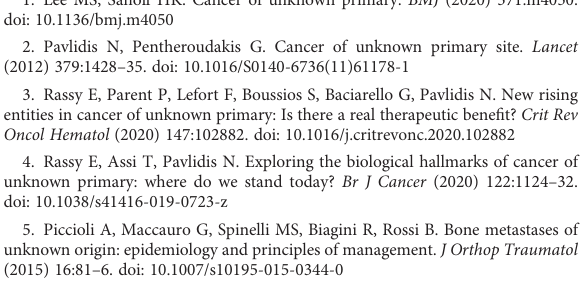
SUPPLEMENTARY FIGURE 1 Learning curves. A. Random Forest; B. Gradient Boosting Machine. SUPPLEMENTARY FIGURE 2 Learning curves. C. Decision Tree; D. eXGBoosting Machine. SUPPLEMENTARY FIGURE 3 Calibration curves for each approach. (A) Random Forest; (B) Gradient Boosting Machine; (C) Decision Tree; (D) eXGBoosting Machine. SUPPLEMENTARY FIGURE 4 The area under the receiver operating characteristic curve in the external validation cohort. SUPPLEMENTARY FIGURE 5 Probability curve in the external validation cohort. SUPPLEMENTARY FIGURE 6 Discrimination slope in the external validation cohort. SUPPLEMENTARY FIGURE 7 Calibration curve in the external validation cohort. SUPPLEMENTARY FIGURE 8 Decision curve analysis in the external validation cohort. SUPPLEMENTARY FIGURE 9 The web